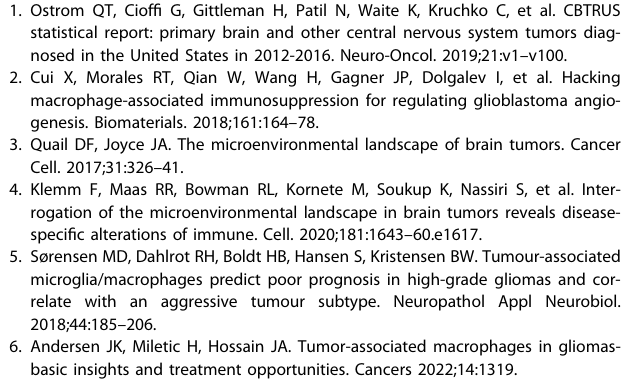
Fig. 7 The CUB1 domain plays a vital role in the interaction of sLRIG3-NETO2 and polarity transformation of TAMs. a Immunoblots for the expression of NETO2, TAM M1 marker CD86 and M2 marker ARG1 in RAW264.7-derived TAMs co-transduced sg-NETO2#3 with Mock, His-NETO2-FL or His-NETO2-Del1 plasmids. b qRT-PCR results of genes encoding TAM M1/M2 marker proteins in RAW264.7-derived TAMs co- transduced sg-NETO2#3 with Mock, His-NETO2-FL or His-NETO2-Del1 plasmids. Values are expressed as relative expression levels to housekeeping gene GAPDH. n = 3 biological replicates. One-way ANOVA with bonferroni correction. c Left panel, representative images of fl ow cytometry for CD86 + TAMs and CD206 + TAMs in RAW264.7-derived TAMs co-transduced sg-NETO2#3 with Mock, His-NETO2-FL or His- NETO2-Del1 plasmids. Right panel, quanti fi cation of CD206 + TAMs in RAW264.7-derived TAMs co-transduced sg-NETO2#3 with Mock, His- NETO2-FL or His-NETO2-Del1 plasmids. n = 3 biological replicates. One-way ANOVA with bonferroni correction. d ELISA for the expression of IL-10 (left panel) and iNOS (right panel) protein in the supernatant medium of RAW264.7-derived TAMs co-transduced sg-NETO2#3 with Mock, His-NETO2-FL or His-NETO2-Del1 plasmids. n = 3 biological replicates. One-way ANOVA with bonferroni correction. e Left panel, representative images of fl ow cytometry for the percentage of TAMs (CD45 + CD11b + F4/80 + ) in leukocytes (CD45 + ) and the percentage of CD86 + or CD206 + TAMs in TAMs in tumor-bearing C57BL/6 mice of different group (GL261 transduced with LRIG3 plasmid and TAMs co-transduced sg- NETO2#3 with Mock, His-NETO2-FL or His-NETO2-Del1 plasmids); Right panel, quanti fi cation of TAMs in leukocytes and CD86 + and CD206 + TAMs in TAMs in tumor-bearing C57BL/6 mice. n = 3 biological replicates. One-way ANOVA with bonferroni correction. f Representative luciferase images of three C57BL/6 mice per group 7 and 14 days after implantation. GL261-luciferase (1.5 × 10 5 cells) cells were transduced with LRIG3 plasmid. TAMs (5 × 10 4 cells) were co-transduced sg-NETO2#3 with Mock, His-NETO2-FL, or His-NETO2-Del1 plasmids. Color scale for GL261 cells: Min = 2.0e5; Max = 5.0e7. g Immunohistochemistry (IHC) for LRIG3, NETO2, ARG1, and IBA1 in GBM established from GL261 transduced with LRIG3 plasmid and TAMs co-transduced sg-NETO2#3 with Mock, His-NETO2-FL or His-NETO2-Del1 plasmids in C57BL/6 mice. Scale bar, 100 mm. ( n = 5/group). One-way ANOVA with bonferroni correction. h Kaplan – Meier survival curves of C57BL/6 mice implanted with GL261 (1.5 × 10 5 cells) transduced with LRIG3 plasmid and TAMs (5 × 10 4 cells) co-transduced sg-NETO2#3 with Mock, His-NETO2-FL or His- NETO2-Del1 plasmids. (Mock ( n = 5/group), His-NETO2-FL ( n = 6/group), His-NETO2-Del1 ( n = 6/group)). Log-rank